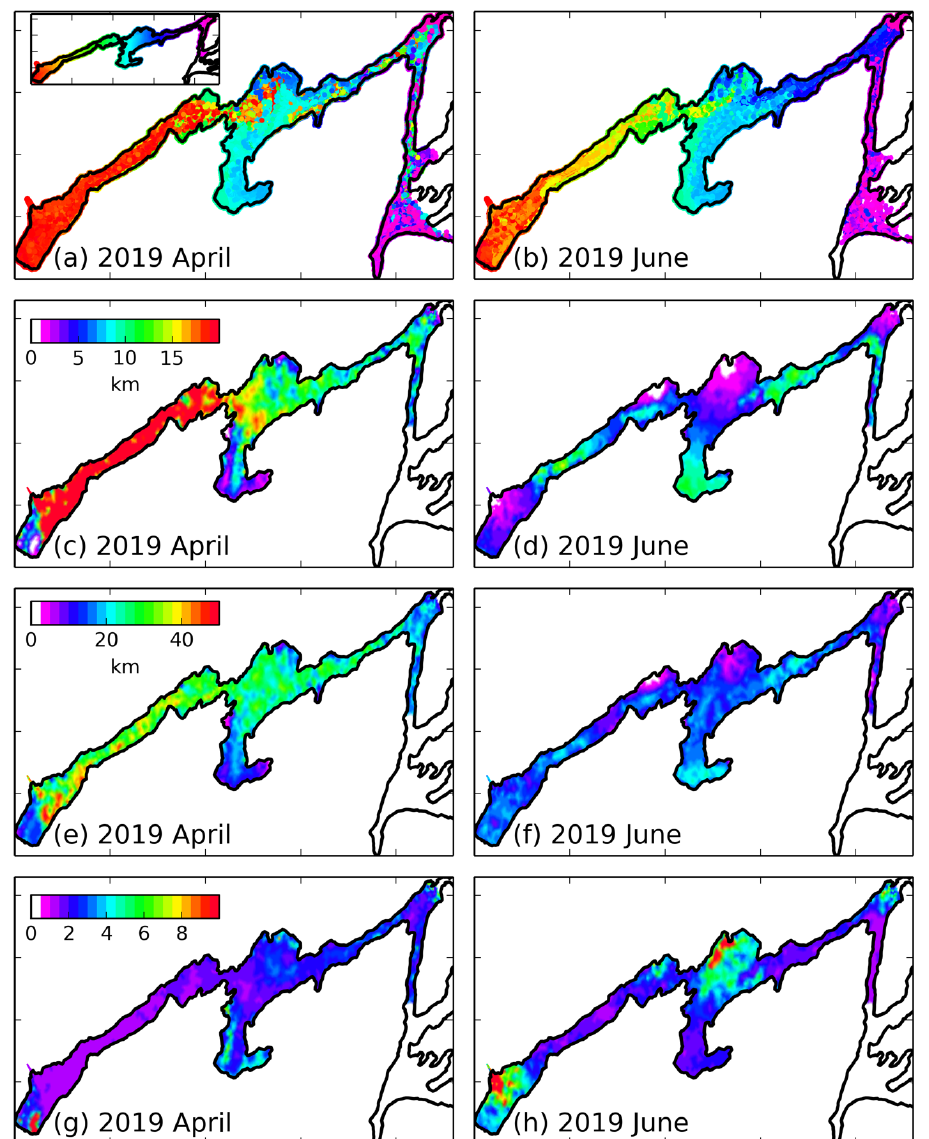
Figure 8. One month of stacked particle positions for releases on ( a ) 1 April and ( b ) 1 June. Inset: initial particle positions and their assigned colors (no particles are released downstream of Line A). Net displacement of particles for ( c ) April and ( d ) June, 2019. Total distance travelled for particles for ( e ) April and ( f ) June, 2019. Tortuosity for particles for ( g ) April and ( h ) June, 2019.